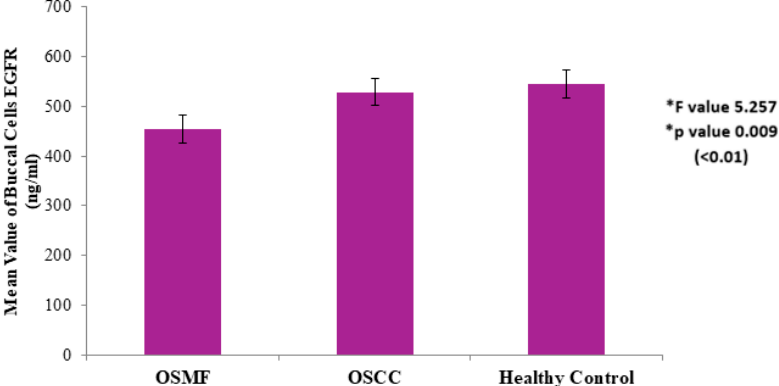
Figure 2. EGFR expression in exfoliated buccal cells in healthy controls vs. OSMF vs. OSCC. * Values are expressed as mean ± SD. Statistical significance analyzed by Dunnett’s T3 post-hoc test at p < 0.01 .